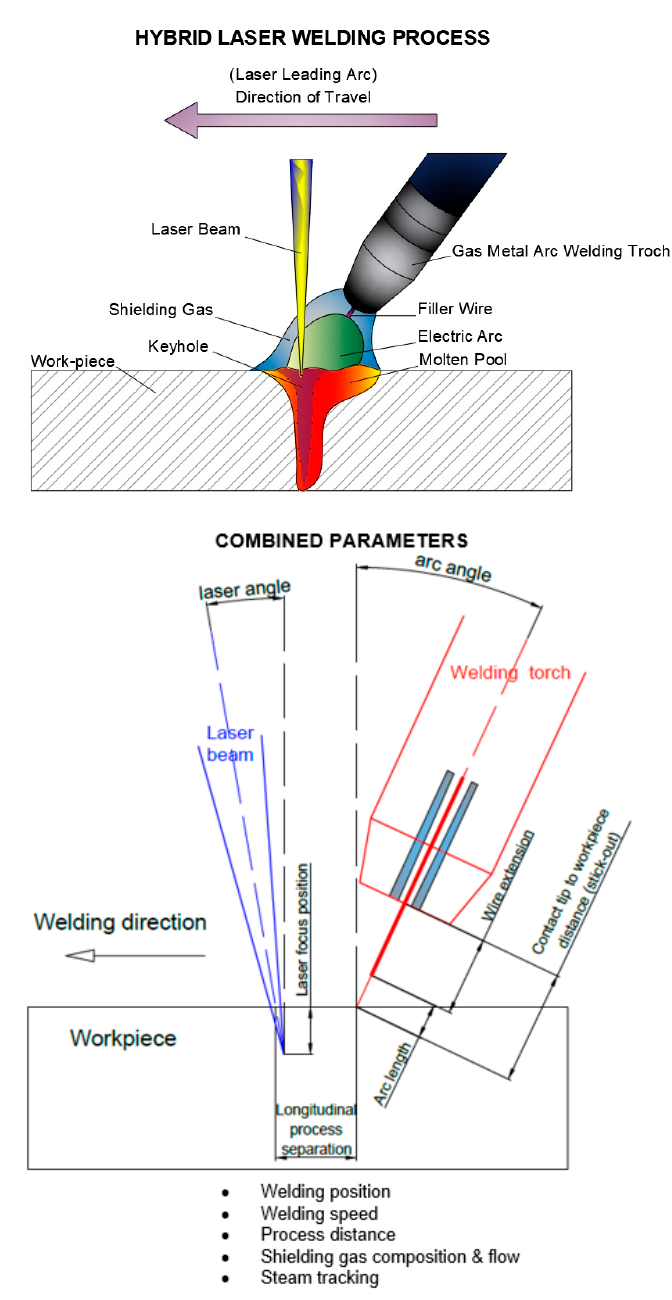
Figure 6. Schemes of hybrid laser-arc welding process and parameters.